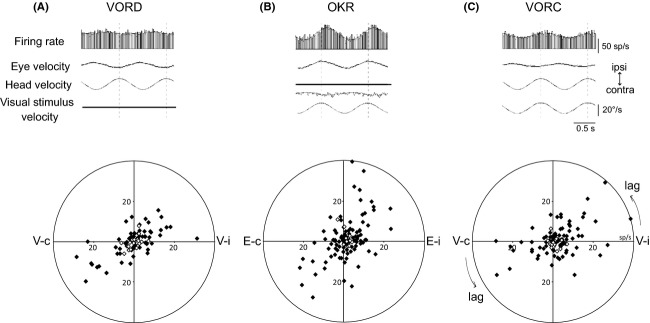
Purkinje cell responses during (A) performance of the VOR in the dark (VORD); (B) the optokinetic reflex (OKR); and (C) cancellation of the VOR (VORC). Top: Responses of a representative Purkinje cell, which responds to ipsiversive eye and head velocity. For illustration purposes, two identical cycles of the means are repeated. Bottom: Summary of the responses in a population of 110 Purkinje cells. Responses are plotted in polar coordinates; the distance from the origin represents the amplitude of the neural response (firing rate modulation relative to the mean) and the angle represents the phase of peak firing relative to the vestibular stimulus (for VORD and VORC) or eye movement (for OKR). A phase of 0° indicates peak firing during peak ipsiversive head velocity (V-i) or eye velocity (E-i). Counterclockwise rotation represents increased phase lag. Cells with a significant response to the test stimulus (p < 0.05, Rayleigh's test) are indicated by filled symbols; open symbols represent cells whose responses did not reach statistical significance.